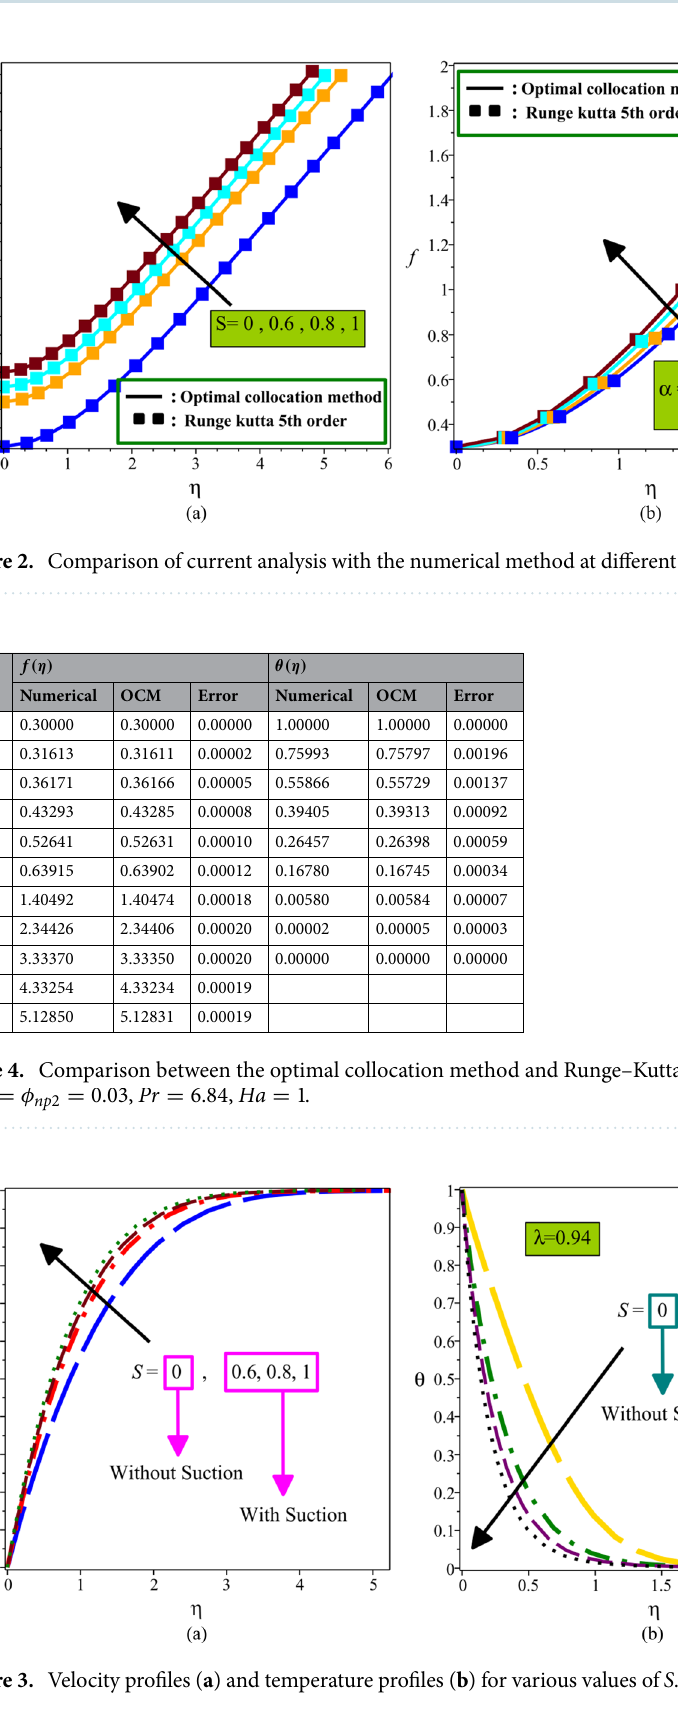
Figure 3. Velocity profiles ( a ) and temperature profiles ( b ) for various values of S